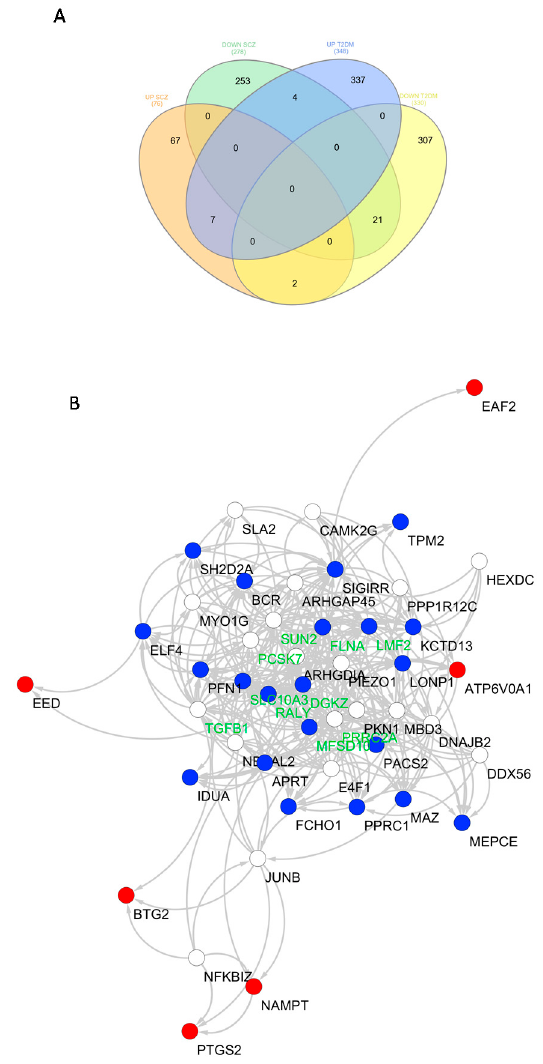
Figure 2. The common differentially expressed genes and pathways between schizophrenia (SCZ) and type 2 diabetes mellitus (T2DM). ( A ) Venn diagram representing common differentially expressed genes (DEGs) between SCZ and T2DM, where up denotes upregulated and down denotes downregulated DEGs. ( B ) A functional network was constructed using the 28 common DEGs between SCZ and T2DM, using the GeneMania prediction server. Overall, the network included 47 nodes. Nodes colored in red represent the commonly upregulated DEGs, while nodes in blue represent the commonly downregulated DEGs between SCZ and T2DM. Nodes labeled in green represent the hub genes of the network. Table 2. Differentially expressed genes concordantly regulated in SCZ and T2DM PBMCs.